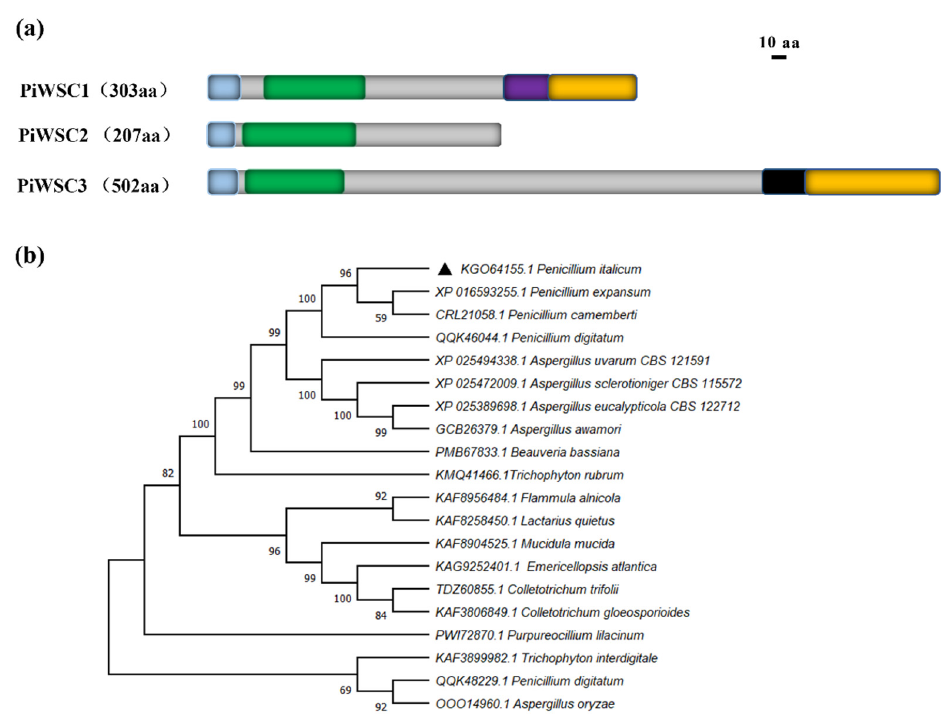
Figure 4. Conserved domains and phylogenetic tree analysis of Piwsc1. ( a ). Prediction of conserved domains of PiWSC protein sequences using InterPro. Diagrammatic representation of the structures of the three PiWSC proteins. Blue rectangles—signal peptides; green rectangles—WSC domains; purple rectangle—SKG6 domain; orange rectangles—cytoplasmic domains; black rectangle—TM_EGFR-like domain. The amino acid sequence length in aa is given for each protein as an indication of scale. ( b ). The evolutionary relationship of Piwsc1 and its homologs from other